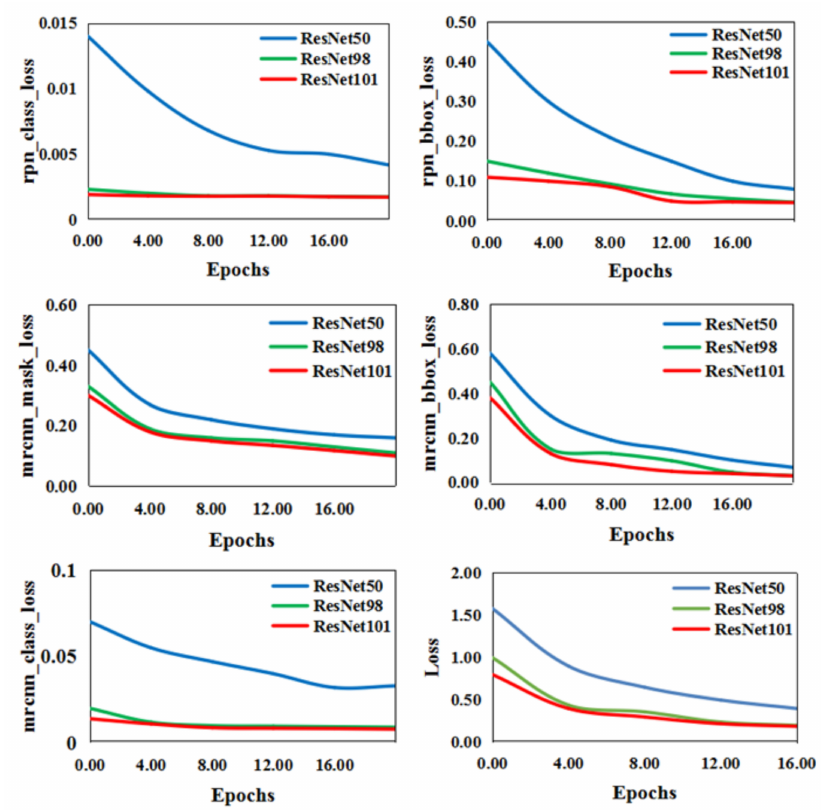
Figure 10. The convergence curves of the six loss functions with different numbers of layers. (ResNet50, ResNet98, and ResNet101 represent the number of layers being 50, 98, and 101, re- spectively. The blue, green, and red lines correspond to convergence of the loss function when the number of ResNet network layers is 50, 98, and 101,